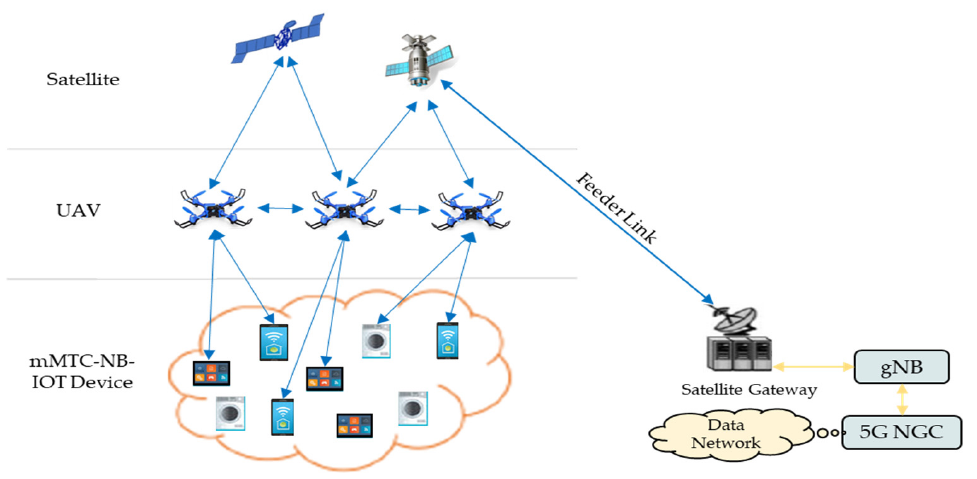
Figure 13. Architecture for integrating IoT device-UAV-satellite and 5G terrestrial network.